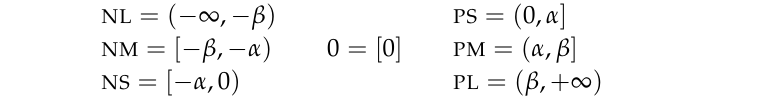
Figure 5. Partition of real line in qualitative